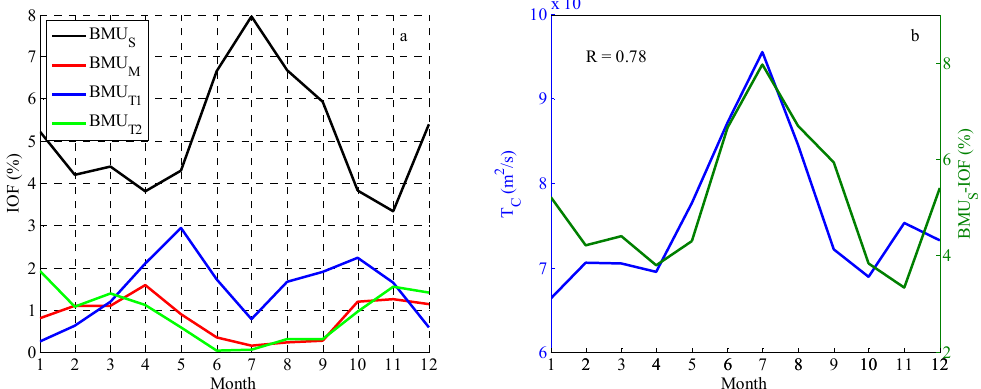
Figure 11. ( a ) Monthly IOFs of the four BMU patterns shown in Figure 8. ( b ) Comparison of surface current transport along Transect B, T C , and IOFs of BMU S at the monthly scale. Correlation coefficient is 0.78 .